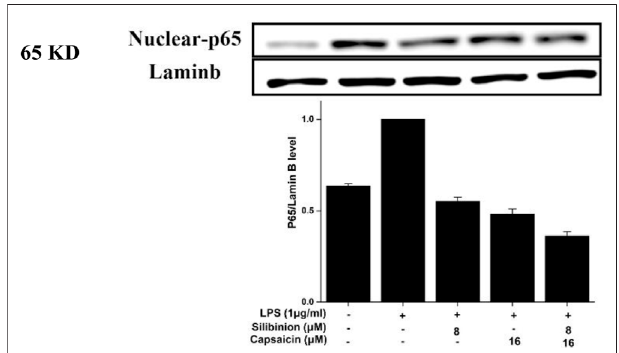
FIGURE 6 | Effect of silibinin and capsaicin on the LPS-induced NF- κ B pathway. After separated by SDSPAGE (8%), transfer to the nitrocellulose membrane, and block for 1 h in non-fat milk (5%), the sample incubated with the primary antibodies p65 overnight at 4 ° C, and subsequently incubation with the secondary antibody for 1